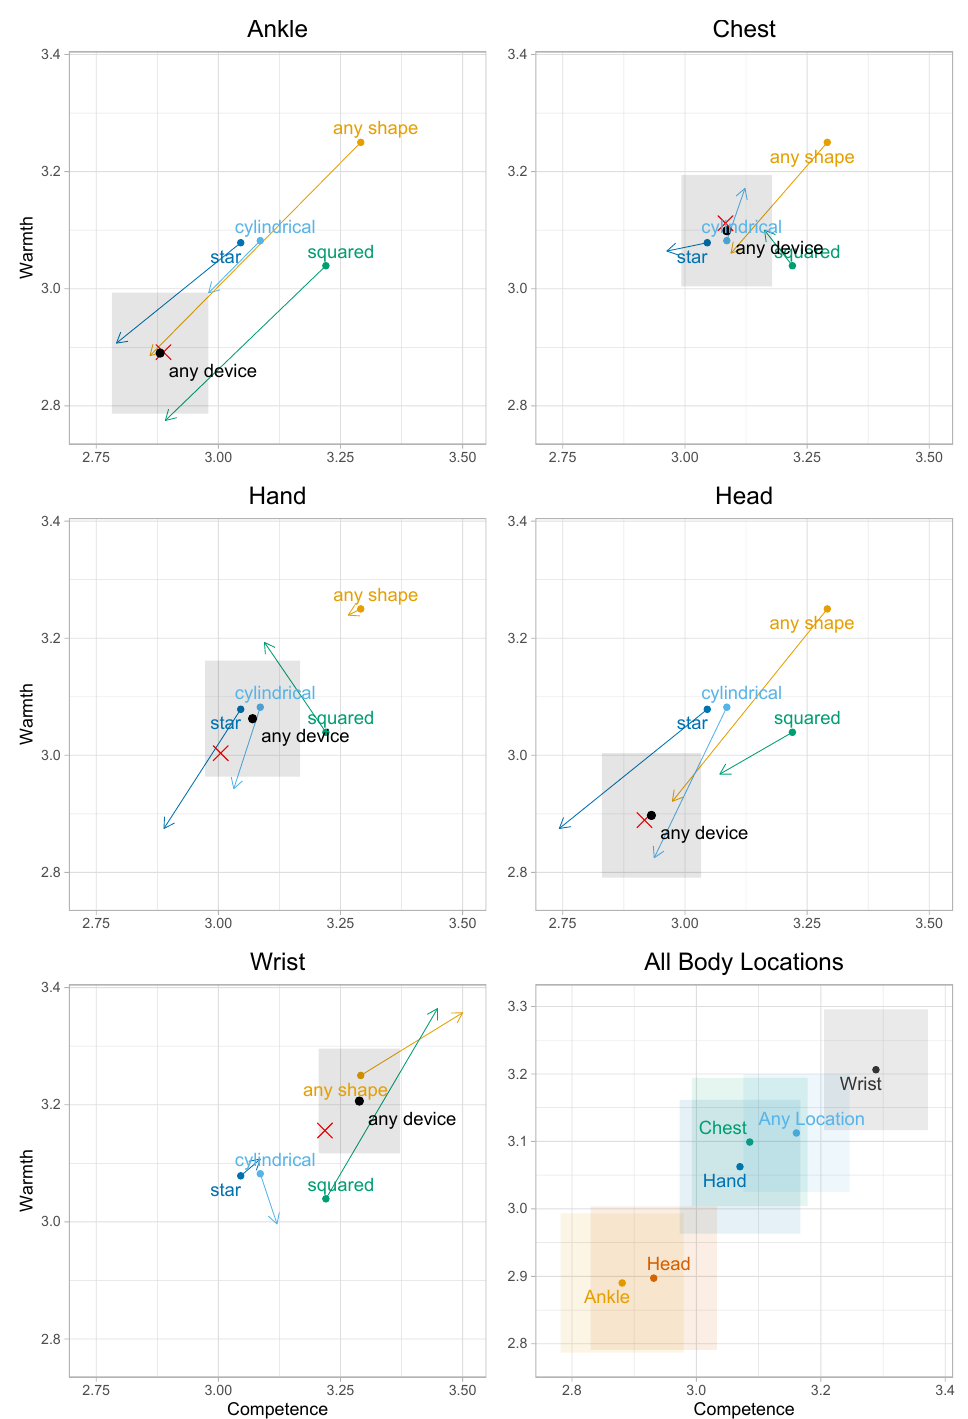
Figure 2. Effect of Shape and Body Location on the ratings of warmth and competence. As predicted, device ratings with different shapes tendentiously shift towards ratings of the body locations. Some ratings, e.g., of cylindrical or star shaped devices on the hand, wrist or chest partially diverge. Highest ratings were measured for wrist-located square devices or any devices. Last diagram below shows mean values of all body location measures. Rectangles show 95% confidence